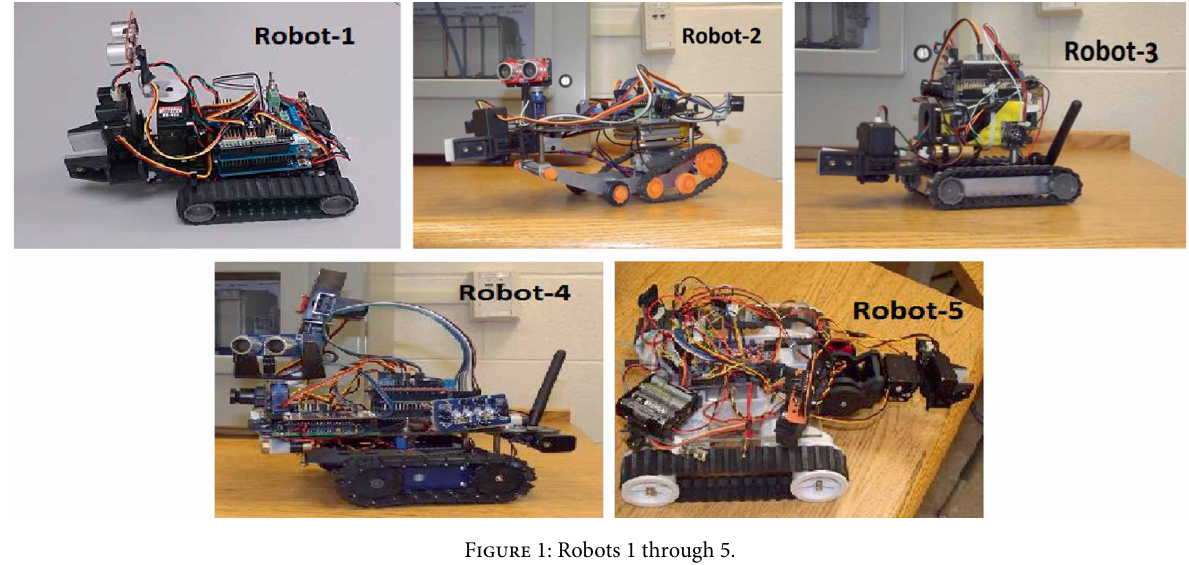
Figure 1: Robots 1 through 5.